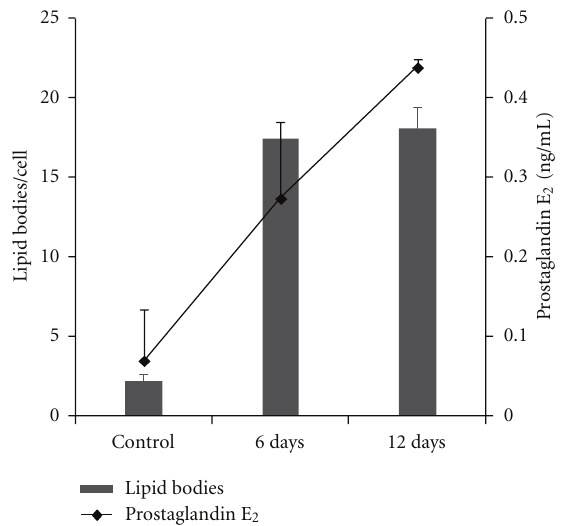
Figure 5: Trypanosoma cruzi infection induces concomitant lipid body formation and prostaglandin E 2 (PGE 2 ) synthesis. Associa- tions between number of lipid bodies (bars) and prostaglandin E 2 (PGE 2 ) peritoneal levels (line) in rats at day 6 or 12 of infection with T. cruzi and in uninfected controls. At both days, the lipid body numbers were significantly increased ( P < 0 . 05) in parallel to an accentuated increase of PGE 2 synthesis. Data are expressed as means ± SEM. Reprinted from [11] with